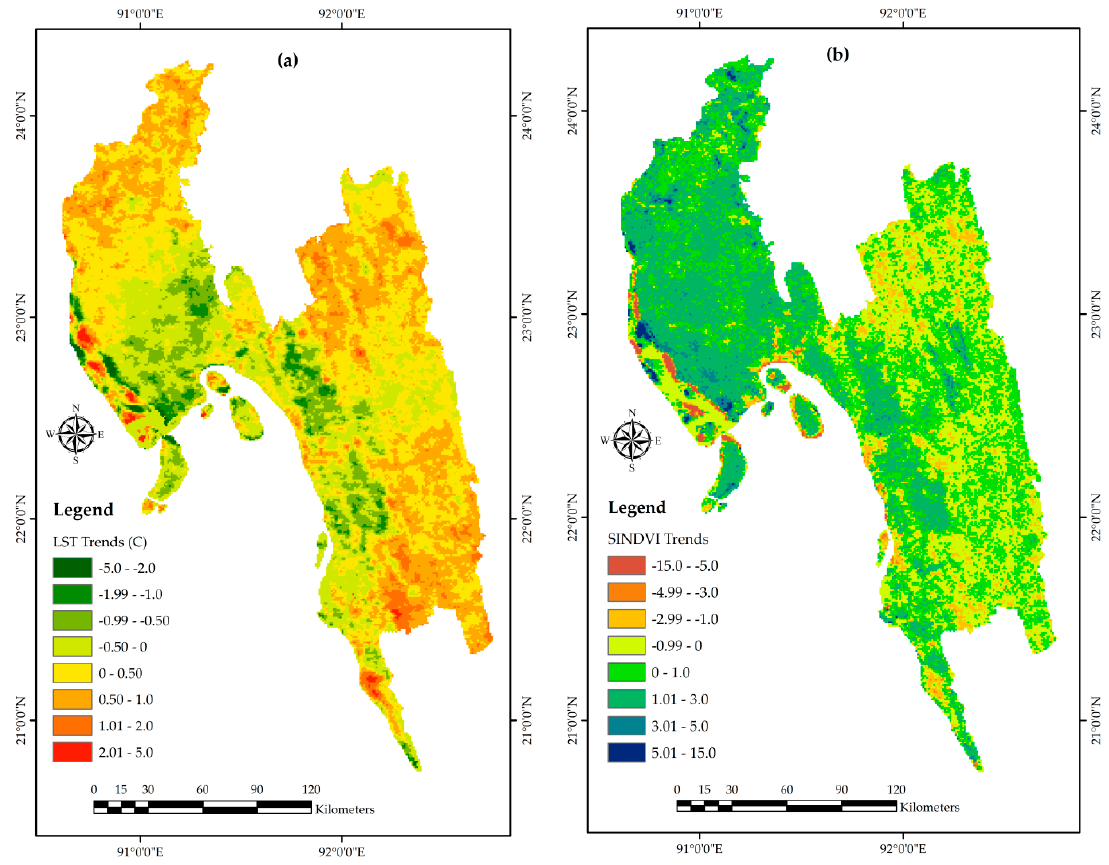
Figure 4. Variation trends of ( a ) LST, and ( b ) seasonally integrated normalized difference vegetation index (SINDVI) during the period of 2001–2016. Regional boundaries were modified from a shape file using ArcGIS 10.2 (Chongqing Engineering Research Center for Remote Sensing Big Data Application, Southwest University, China).